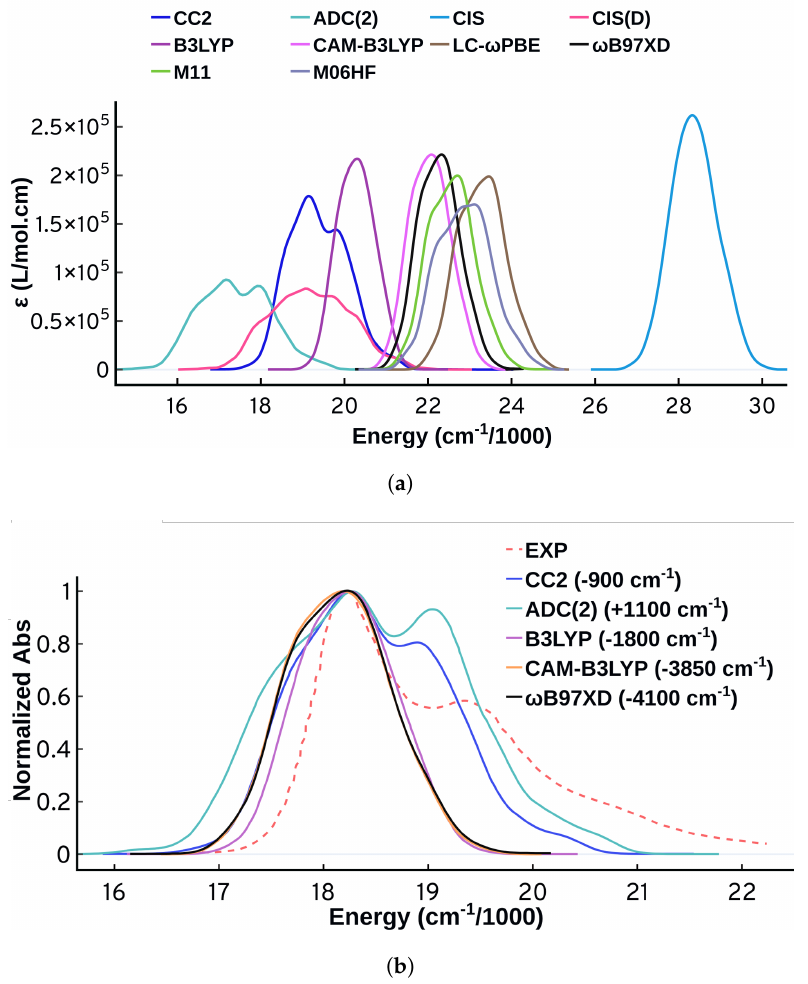
Figure 2. ( a ) Unnormalized absorption spectra from QM/MM-MD calculations using four wavefunction-based methods and six TD-DFT functionals using the same set of configurations (301 configurations). ( b ) Normalized QM/MM-MD absorption spectra shifted so that all the maxima are centered at the experimental maximum of 18,194 cm − 1 (some methods are omitted for clarity). The shift direction and magnitude is included in parentheses. All the spectra were plotted using standard deviation of 250 cm − 1 . The experimental spectrum from the work of Heussman et al. [5] is also